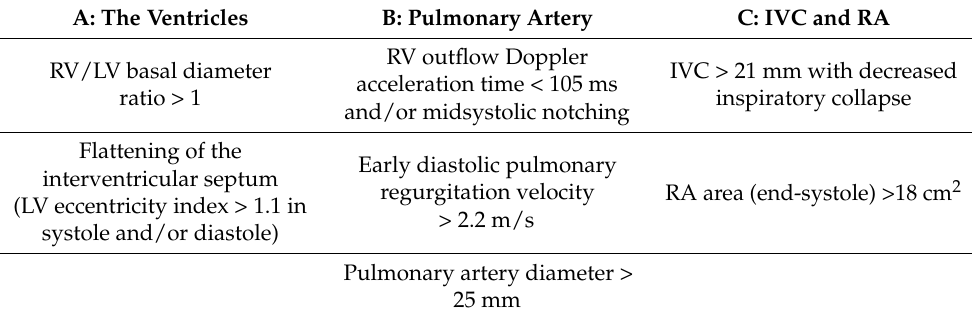
Table 4. Supplementary echocardiographic signs suggestive of PH. Modified after [7].